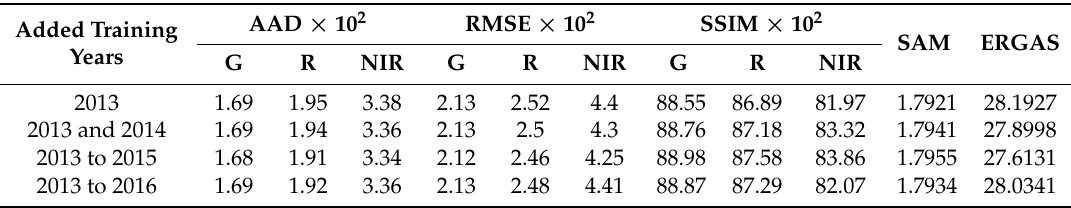
Table 10. Assessment indices from the proposed fusion with the urban data acquired from 2013 to 2016 for modeling reflectance on 12 September